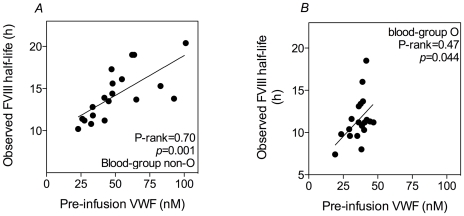
Relation between FVIII half-life and pre-infusion VWF-antigen levels.Panels show the correlation between FVIII half-life and VWF pre-infusion levels in severe haemophiliacs with blood-group non-O (panel A) and blood-group O (panel B). Drawn lines represent best-fit obtained after univariate linear regression.